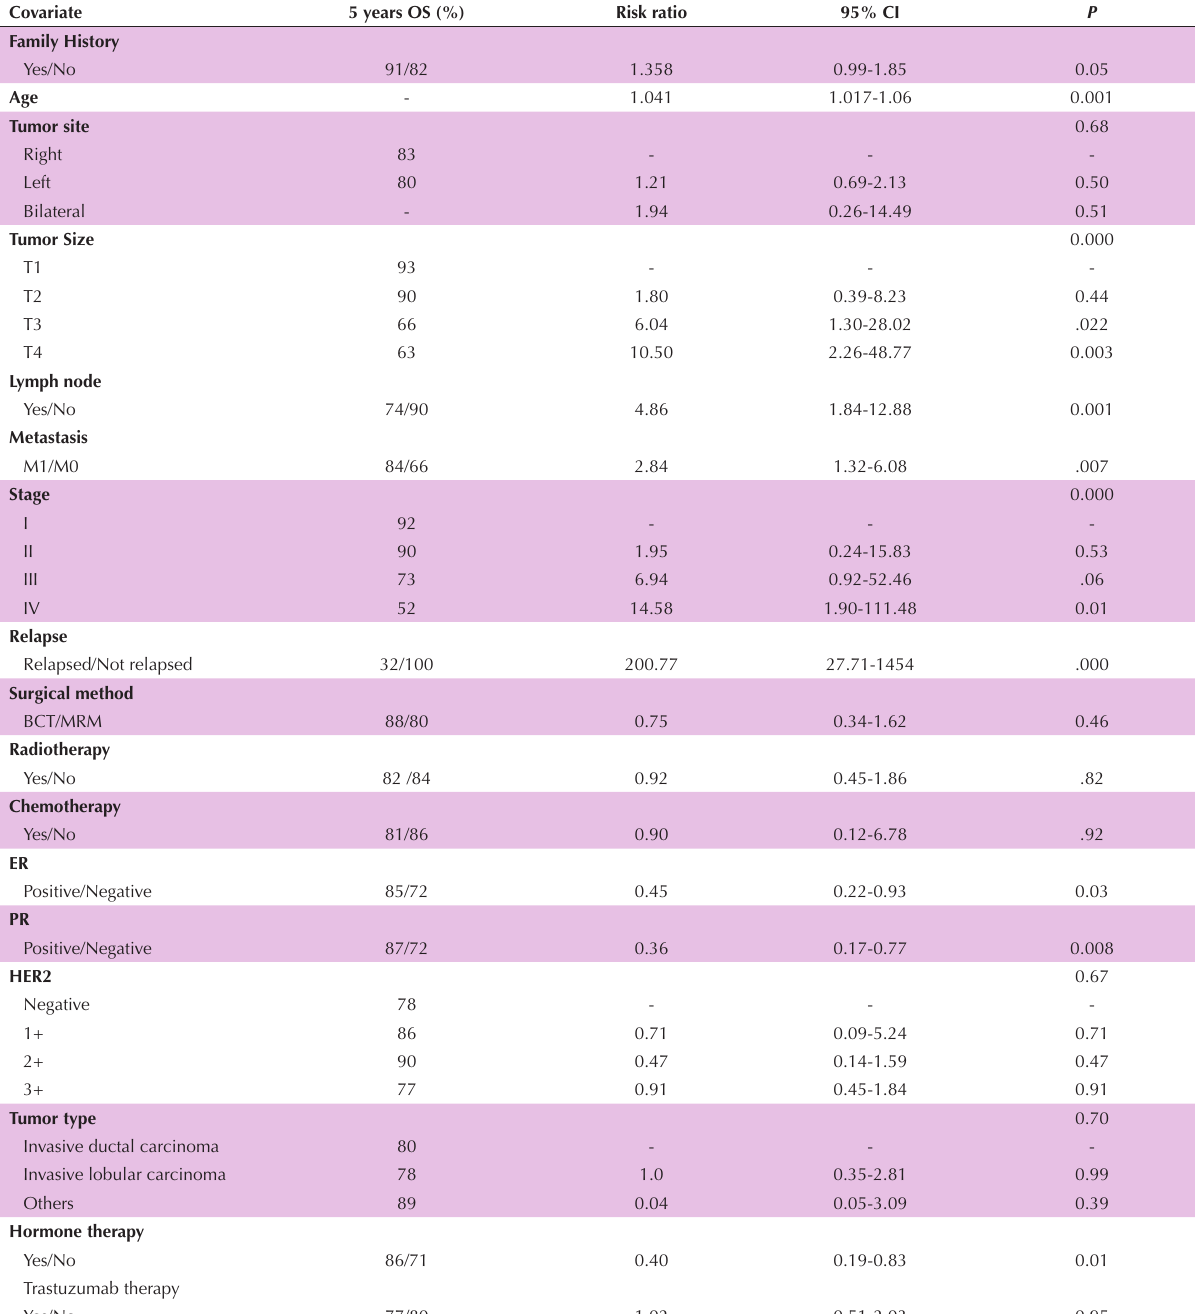
Table 3. Evaluation of factors affecting the survival rate of patients with breast cancer Covariate 5 years OS (%) Risk ratio 95%